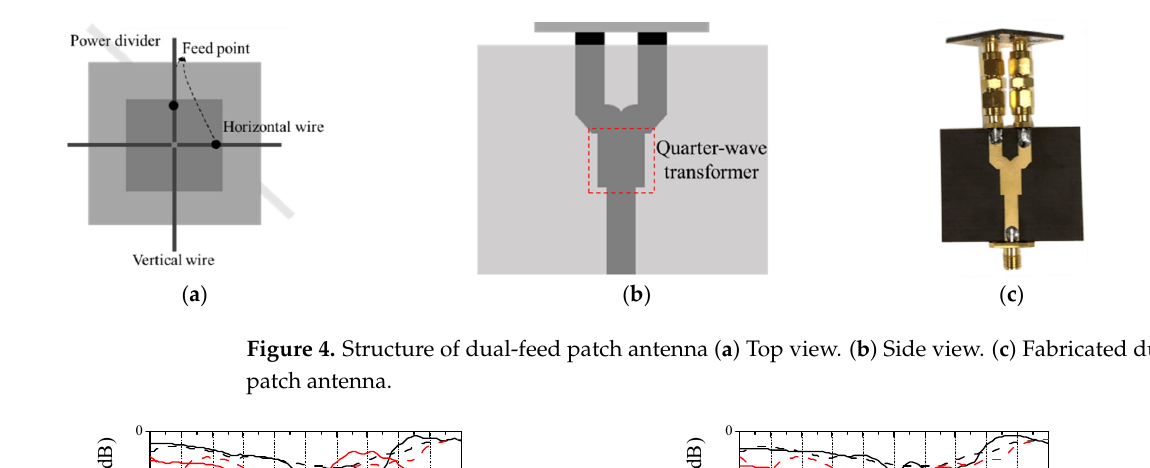
Simulation (Vertical wire without defect) Measurement (Vertical wire without defect) Simulation (Vertical wire with defect)